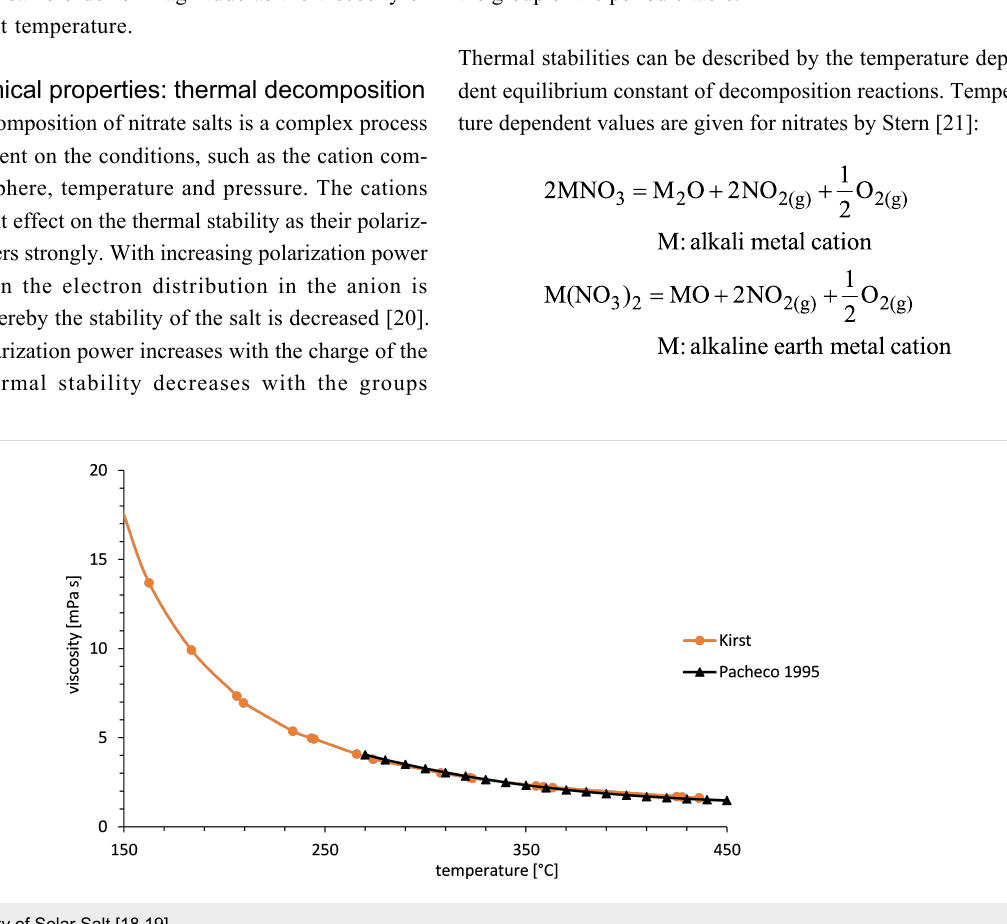
water at ambient